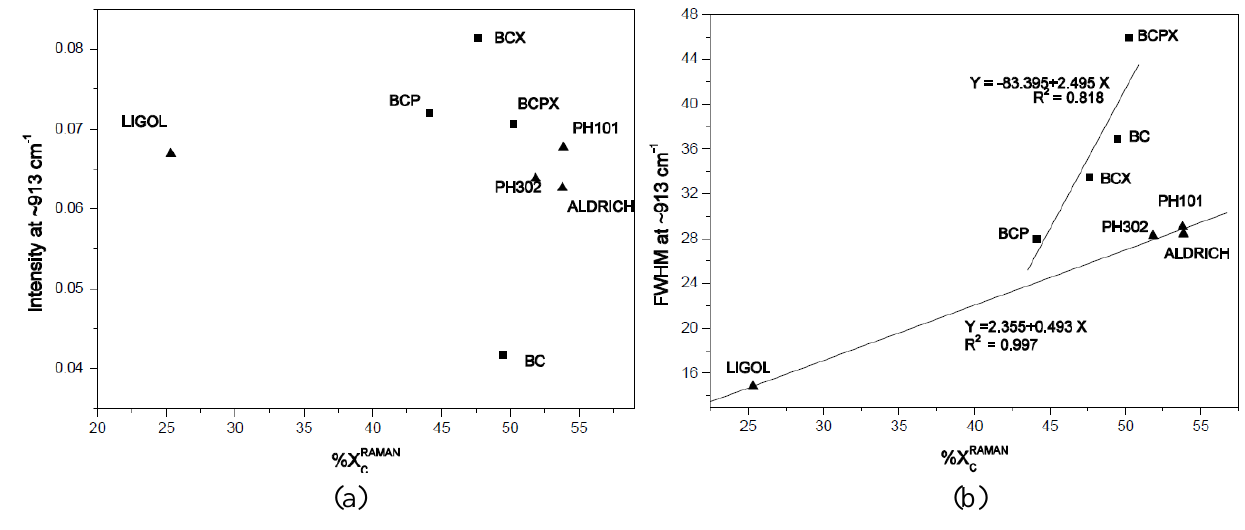
Equation (2) for celluloses of various